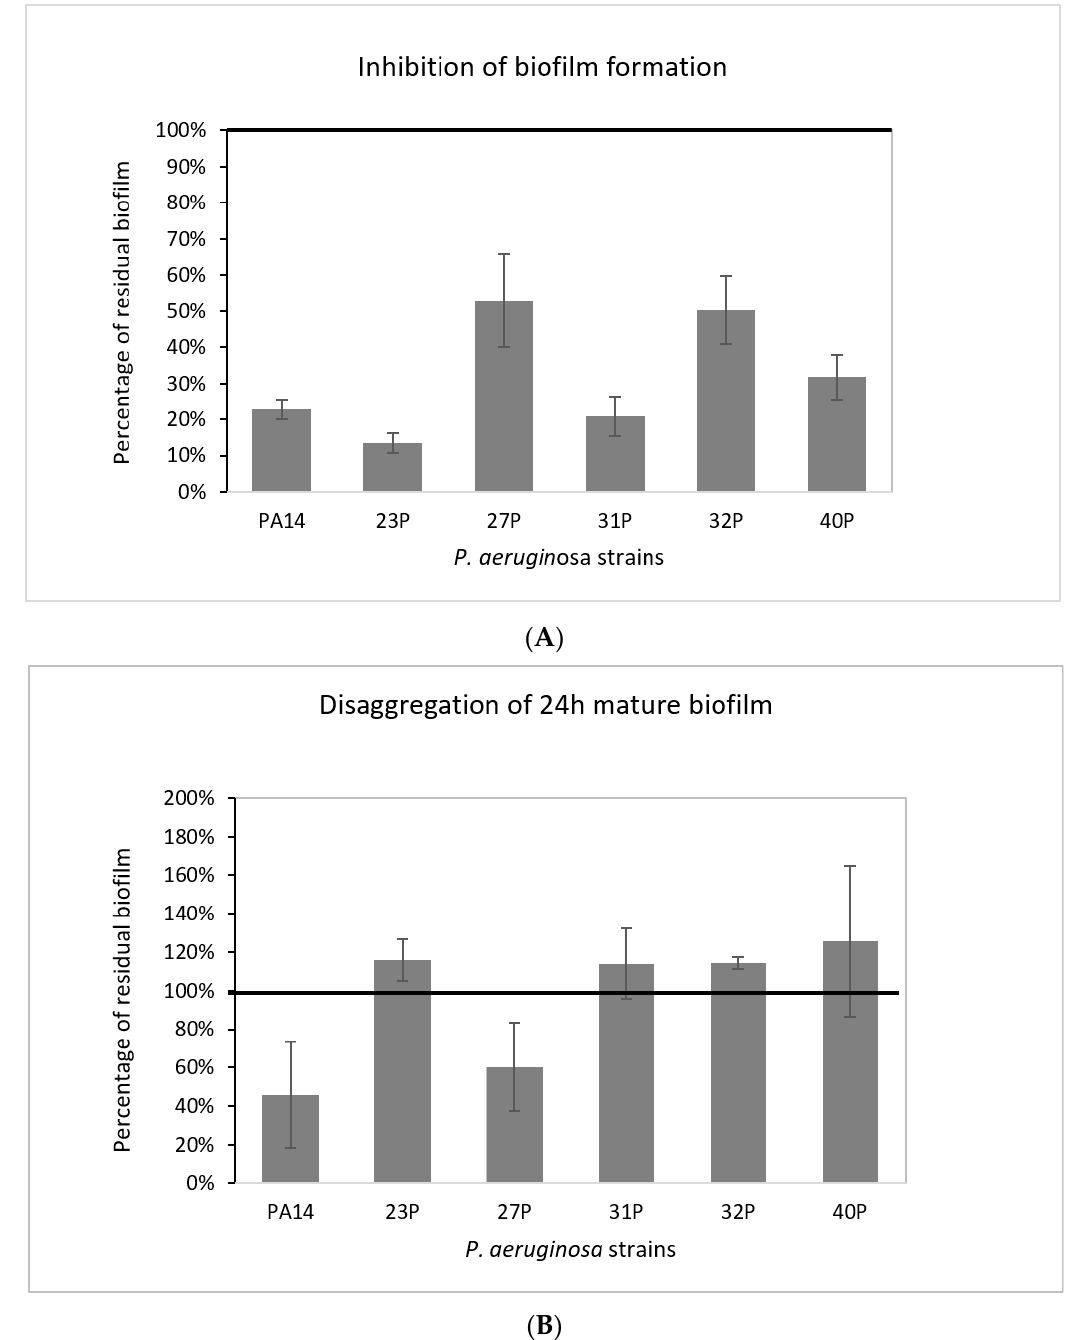
Figure 2. Effect of TAE2020 supernatant (SN_TAE2020) on biofilms of different clinical and reference strains. ( A ) Effect of SN_TAE2020 on biofilm formation. On the ordinate axis, the percentage of bacterial biofilm production is reported. Data are expressed as the percentage of biofilm formed in the presence of SN_TAE2020 compared with the control sample. Each data point is composed of 4 independent experiments, each performed in at least 3 replicates. ( B ) Effect of SN_TAE2020 on 24 h mature biofilm. On the ordinate axis, the percentage of residual biofilm is reported. Data are expressed as the percentage of residual biofilm after 24 h of treatment compared with the control sample. Each data point is composed of 4 independent experiments, each performed in at least 3 replicates.